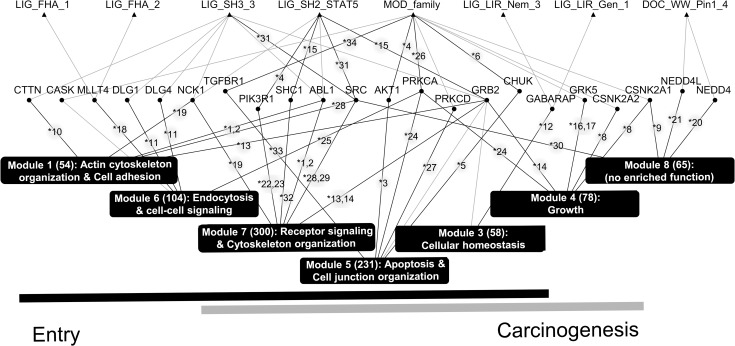
Relationships between SLiMs, R6 VIPs, and network modules.Of the 19 SLiMs identified for HCV E1 and E2 in Fig 1C, 13 (including six grouped in the MOD_family; top row) are directly connected to one or more of the 22 R6 VIPsdirect (middle row) in the virus-host PPI network (Fig 2). The MOD_family contains MOD_CK1_1, MOD_CK2_1, MOD_GSK3_1, MOD_NEK2_1, MOD_NEK2_2, and MOD_ProDKin_1; all are targets of a kinase. An R6 VIPdirect and a module(s) (bottom, boxed in black) are considered to be connected if more than 10% of the interacting partners of the VIPdirect belong to the module. Based on this criterion, module 2 is not connected to an R6 VIPdirect and, therefore, is not included in the figure. The validity of the connections displayed as solid dark lines is supported by published experimental evidence. The corresponding reference number(s) (indicated by an asterisk) are provided in S3 Table. The dark and light horizontal bars at the bottom of the figure identify modules with the functionality of entry and/or carcinogenesis, respectively.